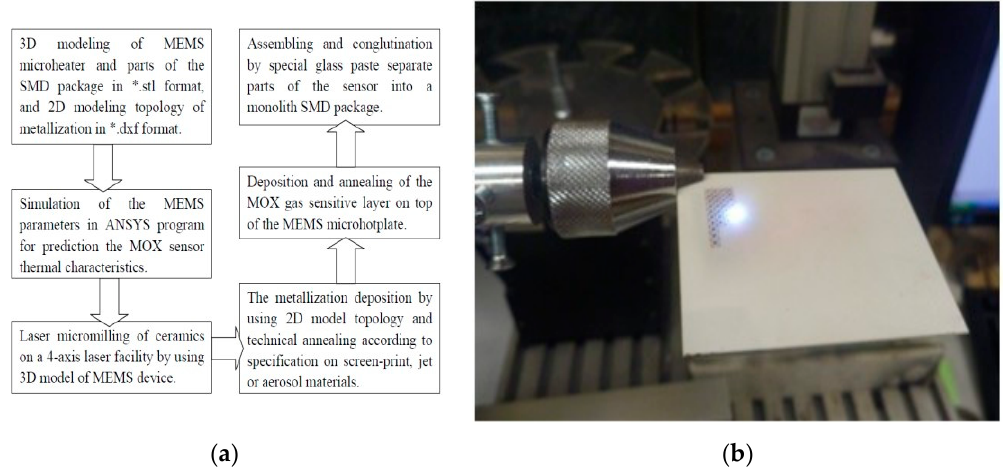
Figure 1. ( a )The technological route of manufacturing MEMS device in SMD package; ( b ) Photo of micromilling by 4-axis CNC 1064 µm wavelength fiber laser tool 250 µm thick Al 2 O 3 substrate during fabrication microhotplates for MOX gas sensor.